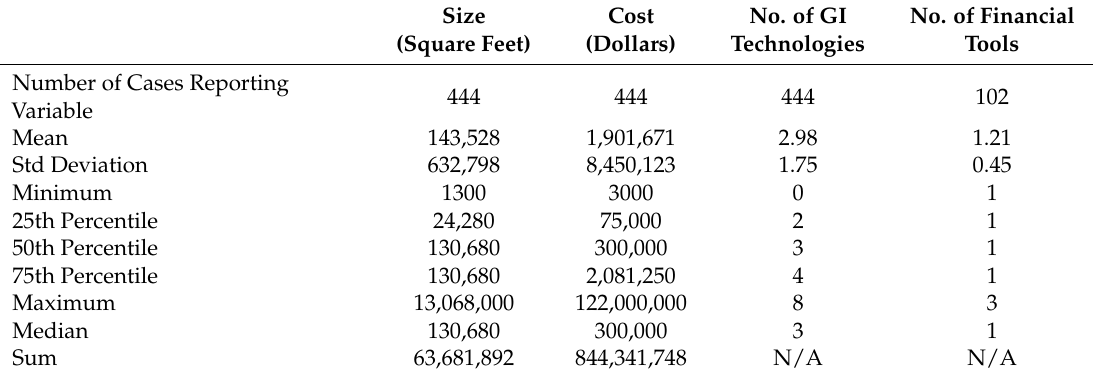
Table 3. Descriptive statistics for the major parameters in the ASLA convenience